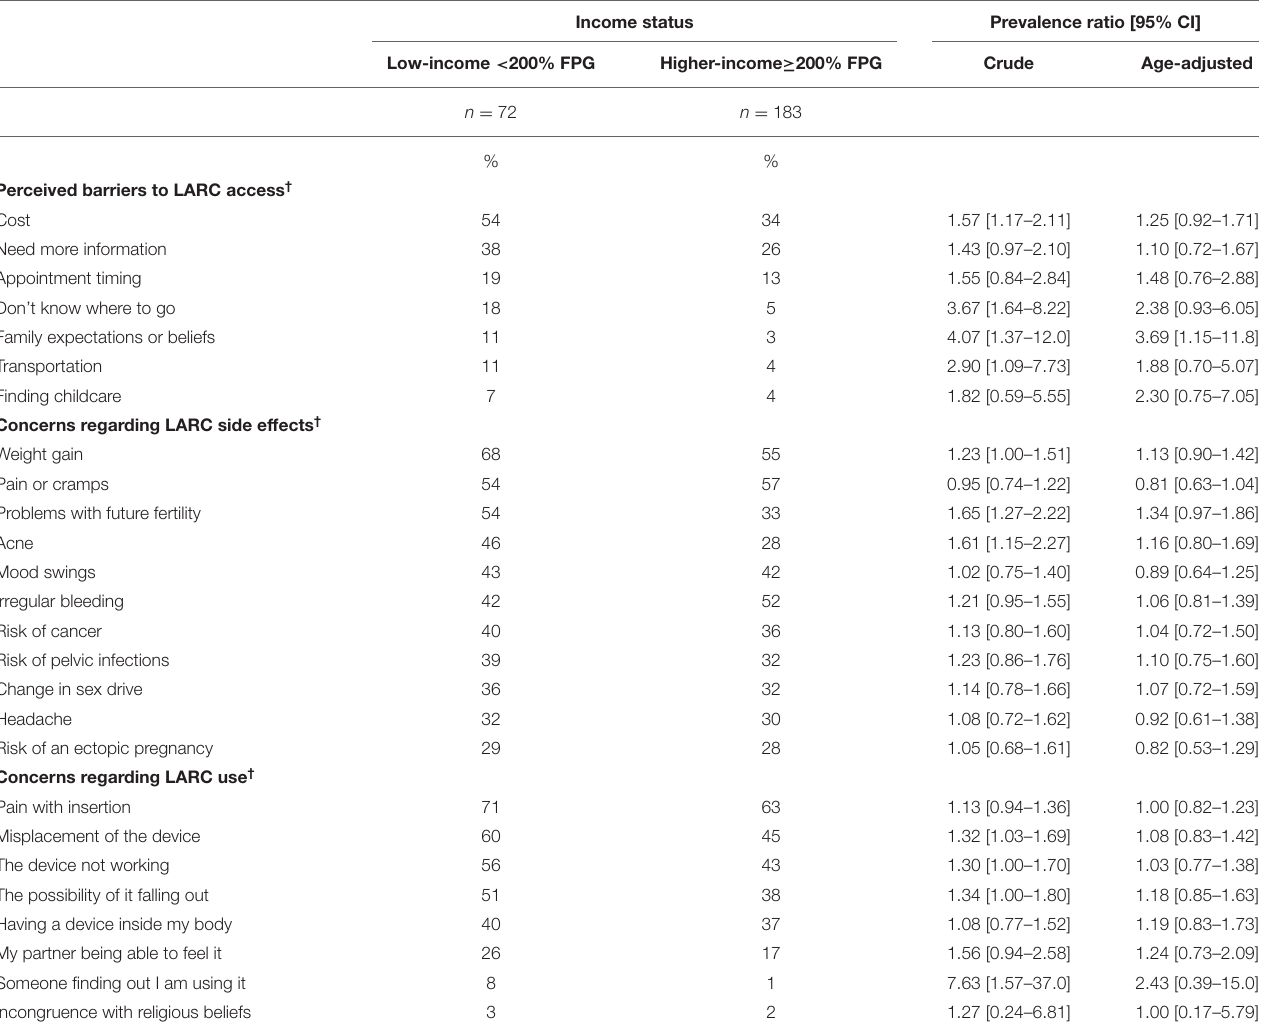
TABLE 2 | Perceived LARC barriers by income